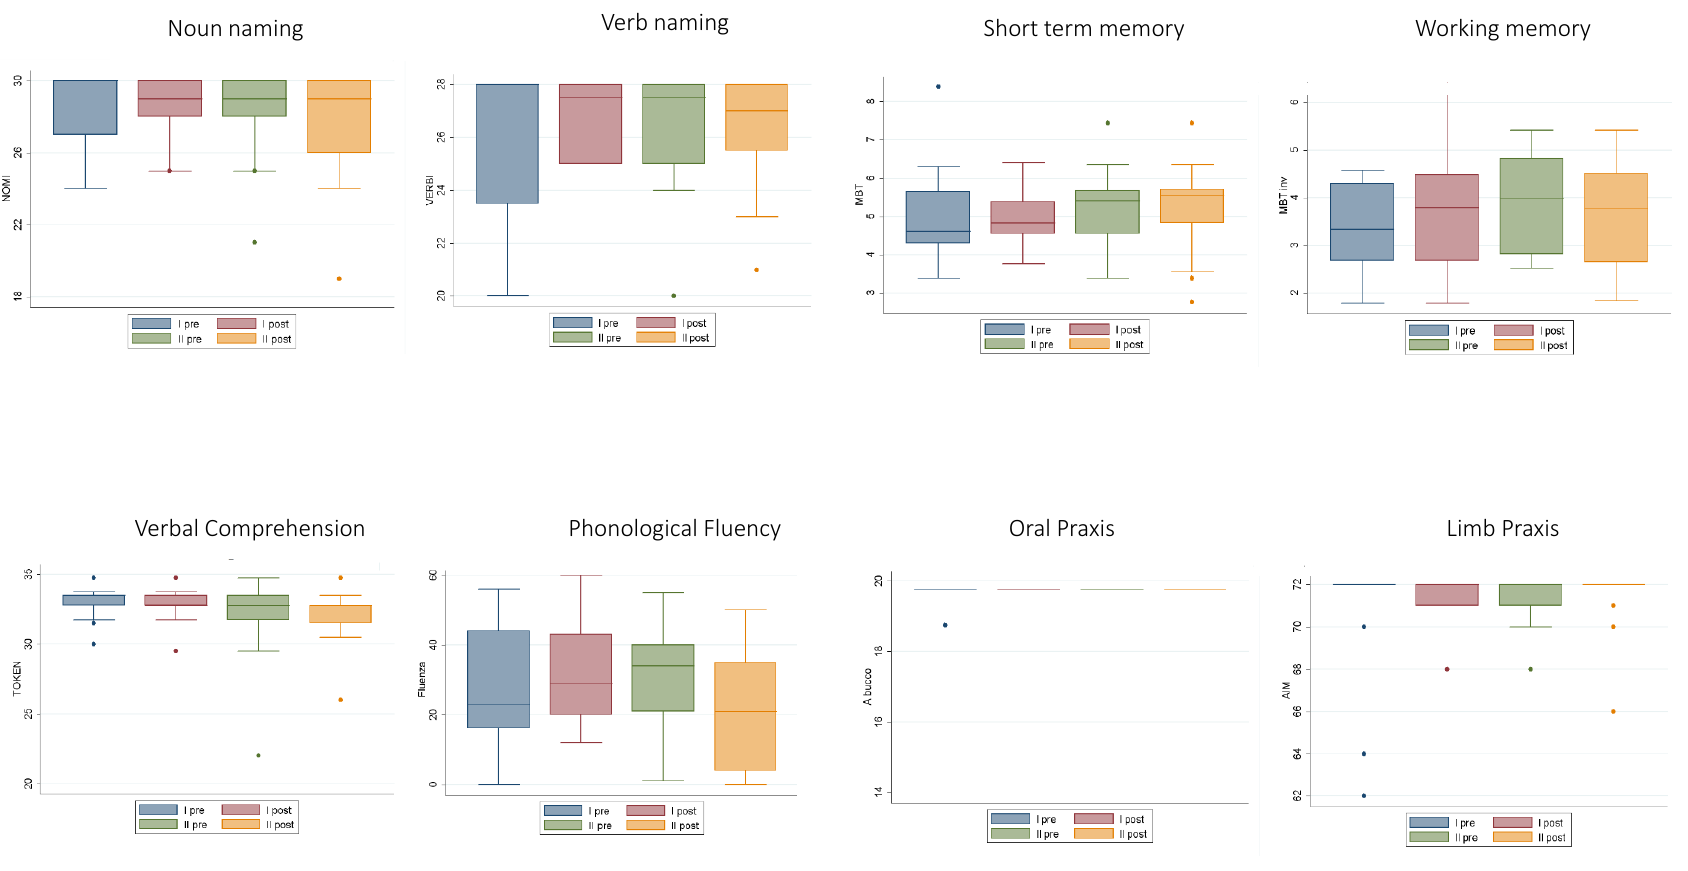
Figure 6. Mean performance of the 17 patients with recurrent glioma T1 and T2 (pre- and post-first surgery, respectively) and T3 and T4 (pre- and post-recurrence surgery, respectively). Bars represent the standard